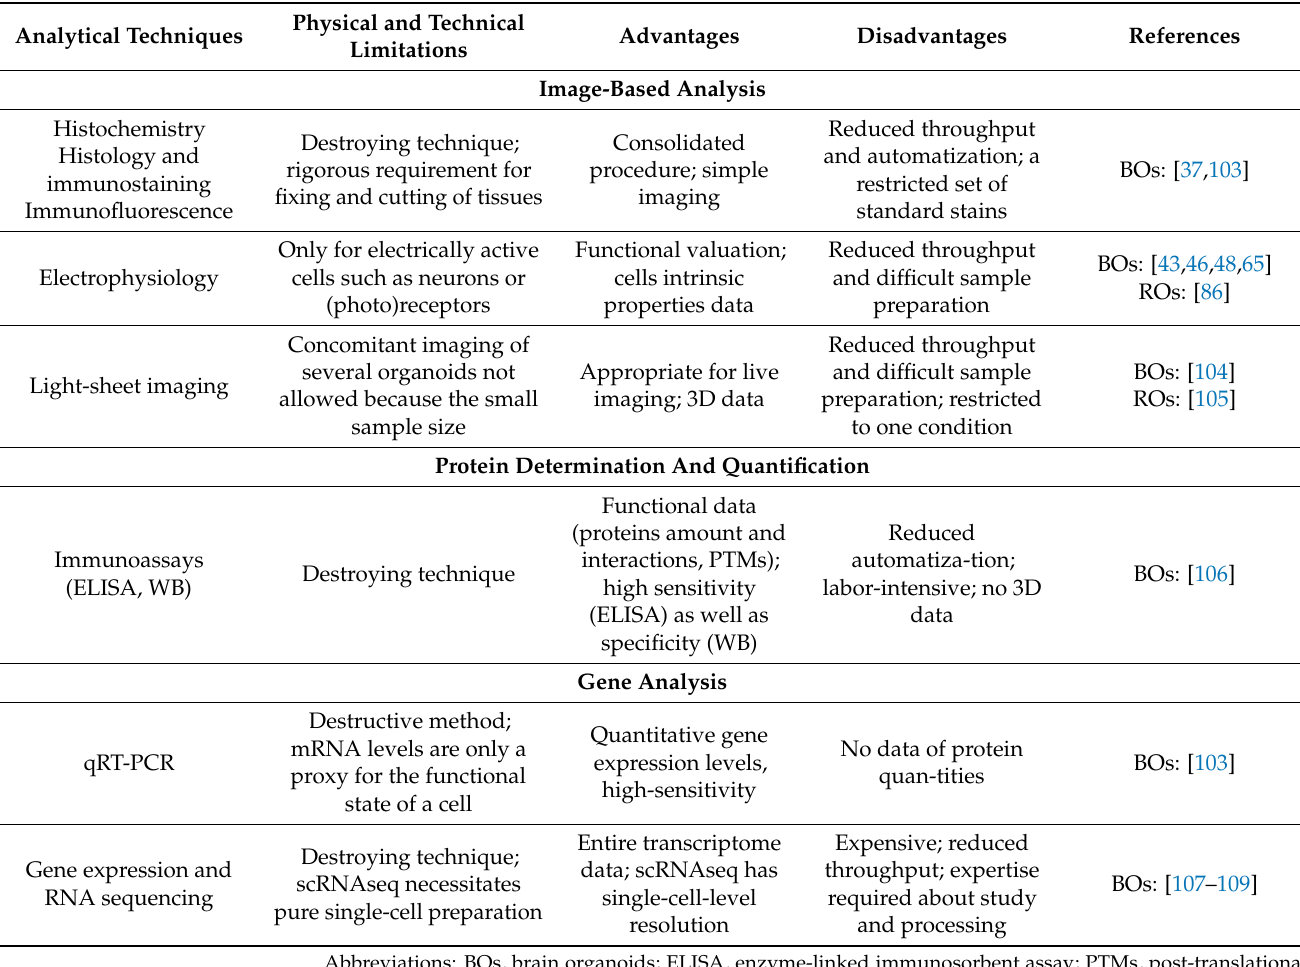
Table 2. Analytical techniques in brain and retinal organoids